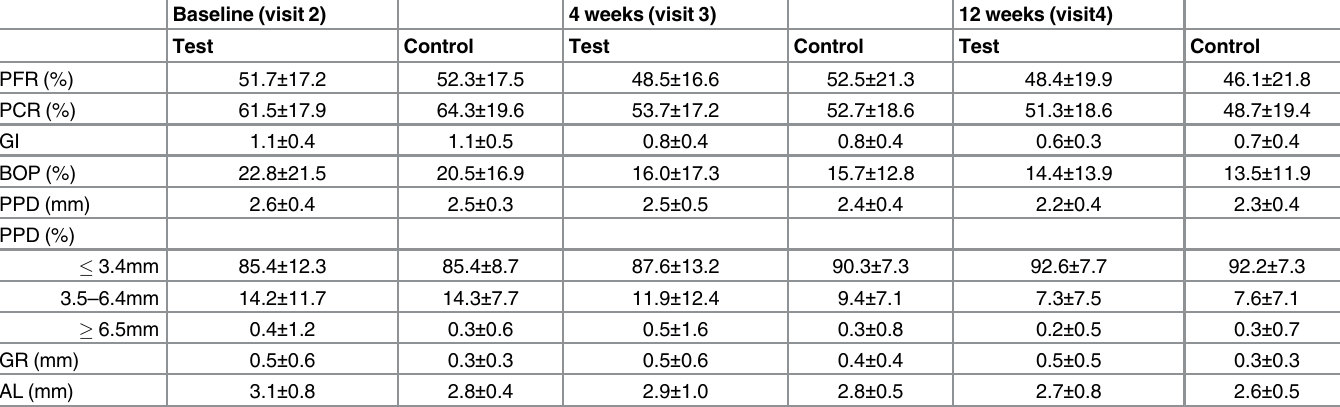
Table 2. Clinical parameters at baseline and follow ups (means ±